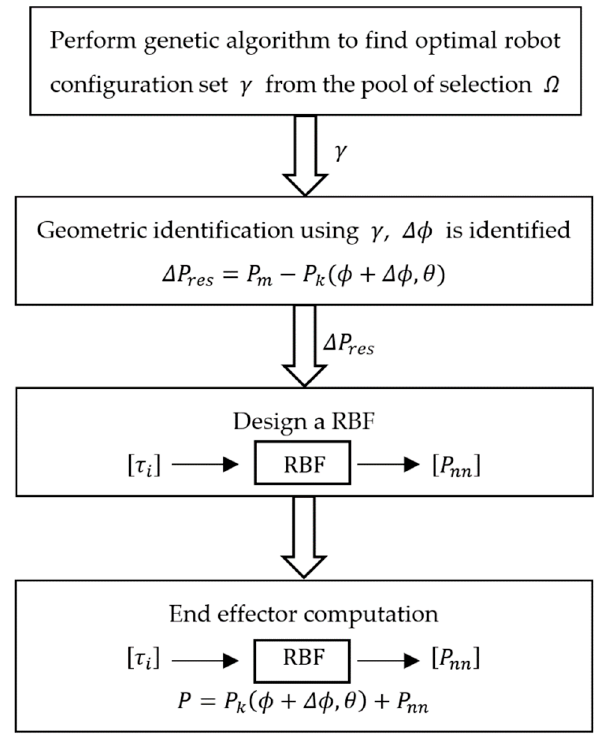
Figure 3. Flowchart of the proposed method.